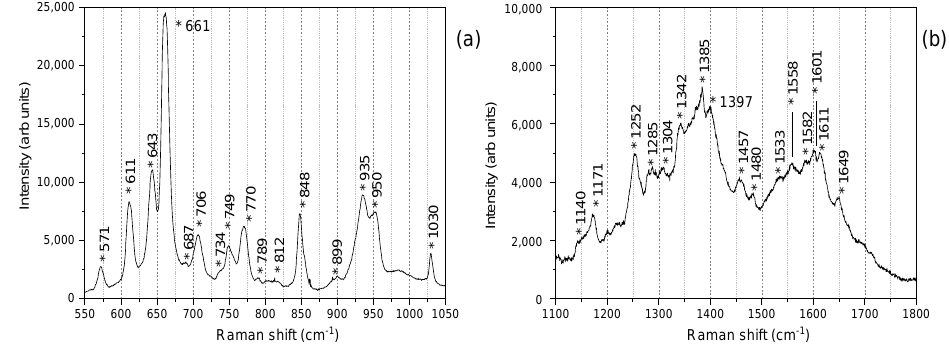
Figure 5. Details of the acquired genome SERS spectrum: ( a ) the spectral region between 550 and 1050 cm −1 and ( b ) range between 1100 and 1800 cm −1 .